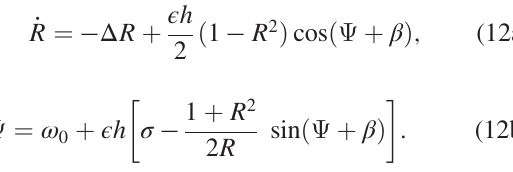
FIG. 1 (color online). (a) Phase diagram of model (1) obtained from the reduced Eq. (12), with β ¼ σ ¼ 0 and n ¼ 10 . Inset: Pulselike function [Eq. (3)]. Panels (b) – (g) show results obtained from the numerical integration of the Winfree model [Eq. (1)], with N ¼ 2000 oscillators and the natural frequencies selected deterministically to represent the Lorentzian distribution: ω ¼ 1 þ Δ tan ½ π = 2 ð 2 i − N − 1 Þ = ð N þ 1 Þ(cid:1) , for i ¼ 1 ; :::::; N . Two different points ( open square, open circle) corresponding to the i synchronous (b),(d),(f), and asynchronous (c),(e),(g) states were chosen. (b),(c) Coupling-modified frequencies: Ω R : θ ð t Þ dt versus the oscillators ’ index i . We observe that in the synchronization region, plateaus in Ω appear at a basic t t − 1 lim 0 t → ∞ i frequency and its integer multiples; other plateaus at rational multiples of the basic frequency are absent due to the purely sinusoidal ¼ 0 ). (f),(g) Time series of the modulus of the form of the PRC; see Ref. [33]. (d),(e) Raster plots (points depicted whenever θ P i e i θ j j and the mean field h ð t Þ Kuramoto order parameter R ð t Þ ¼ j N − 1 j